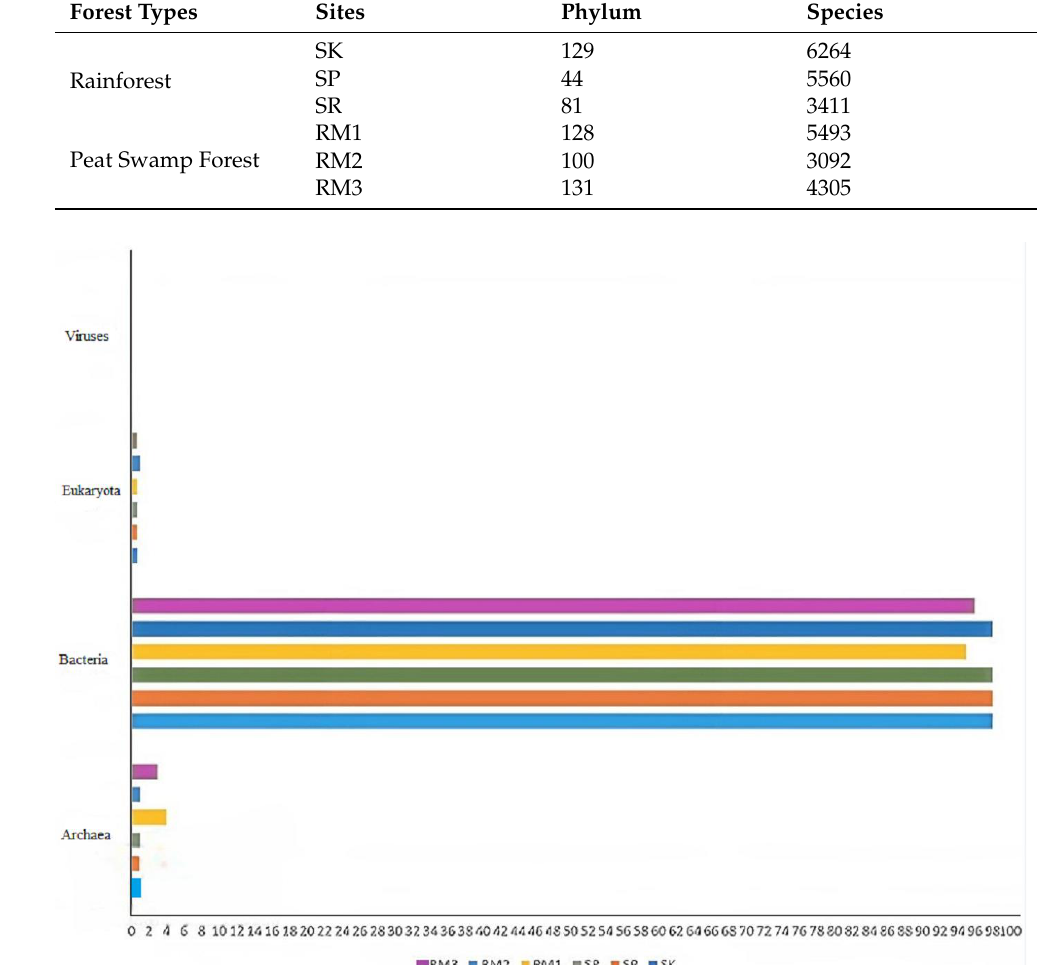
Figure 1. Microbial community domain in Royal Belum and Raja Musa soils generated with MGRAST .